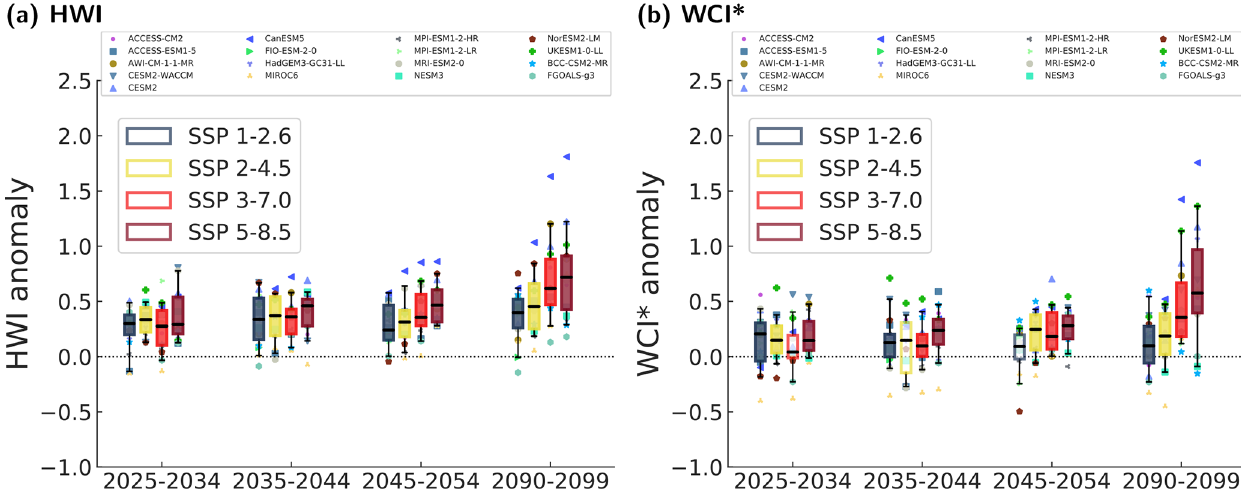
Figure 4. Future HWI (a) and WCI ∗ (b) changes from the present day (1979–2014). Coloured boxes represent the range between the first and the third quartiles of the probability distribution of index anomalies in scenarios (SSPs 1–2.6, 2–4.5, 3–7.0, and 5–8.5) during periods of 2025–2034, 2035–2044, 2045–2054, and 2090–2099. Boxes are filled if the change is significant at the 90% confidence level according to a two-tailed t test. Black bars represent the median of distributions. Black whiskers represent the range between the 5th and 95th percentile of the probability distribution of index anomalies. Model mean values are represented by markers with different shapes and colours. WCI ∗ = − 1 × WCI. Details are given in Sect. 2.